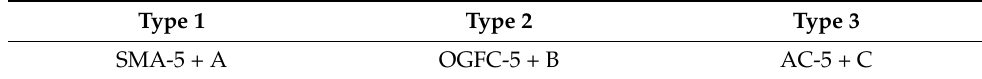
Table 3. Three types of VTAO mixtures.